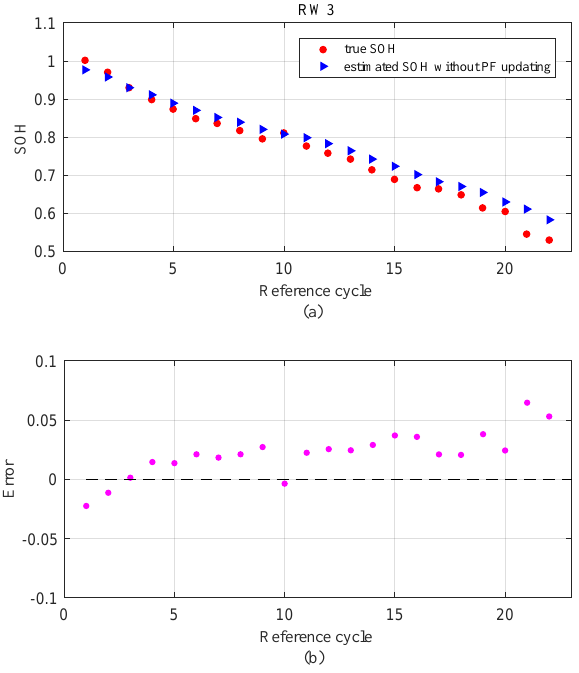
Figure 13. ( a ) State-of-health (SOH) estimation results and ( b ) estimation errors for battery RW3 using indirect HIs without particle filter (PF) updating.